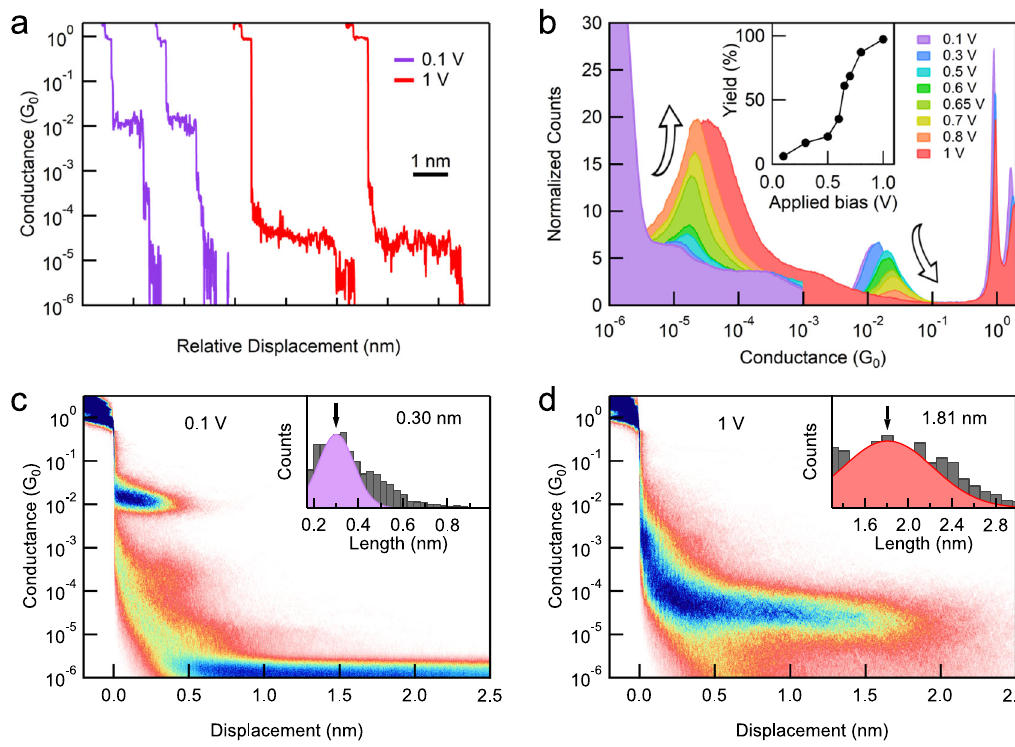
Fig. 2 | Bias-dependent STM-BJ measurement results of [6]CPP. a Sample con- ductance traces for [6]CPP measured at an applied bias of 0.1 and 1V. b One- dimensional(1D)conductancehistogramsfor[6]CPPmeasuredatdifferentapplied